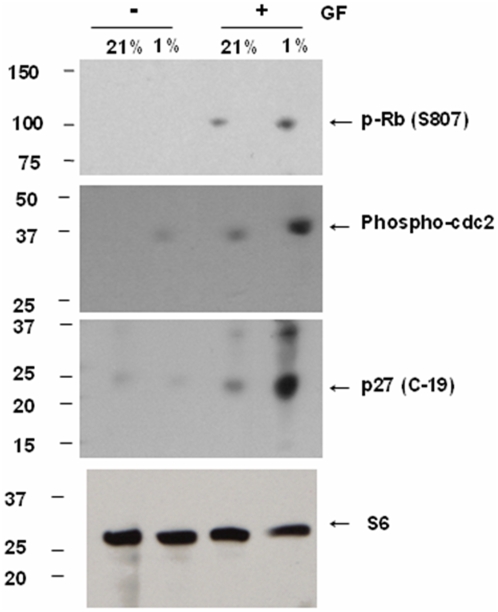
Changes in OL cell cycle proteins in 1% O2.Whole cell lysates from OLs cultured at 21% O2 or 1% O2 in the presence or absence of GFs, were analyzed by immunoblot analysis for phosphorylation state of cell cycle proteins Rb and cdc2, and for the negative regulator of cell cycle, p27Kip1. Ribosomal S6 protein was used as a loading control. The approximate sizes for Rb, cdc-2, p27Kip1 and ribosomal S6 protein are 110 kDa, 34 kDa, 27 kDa and 32 kDa, respectively. Representative Western blot from 3 different preparations shows an increase in phosphorylated forms of Rb and cdc-2, and total p27Kip1 levels in hypoxia. Data shown are representative of three separate studies.